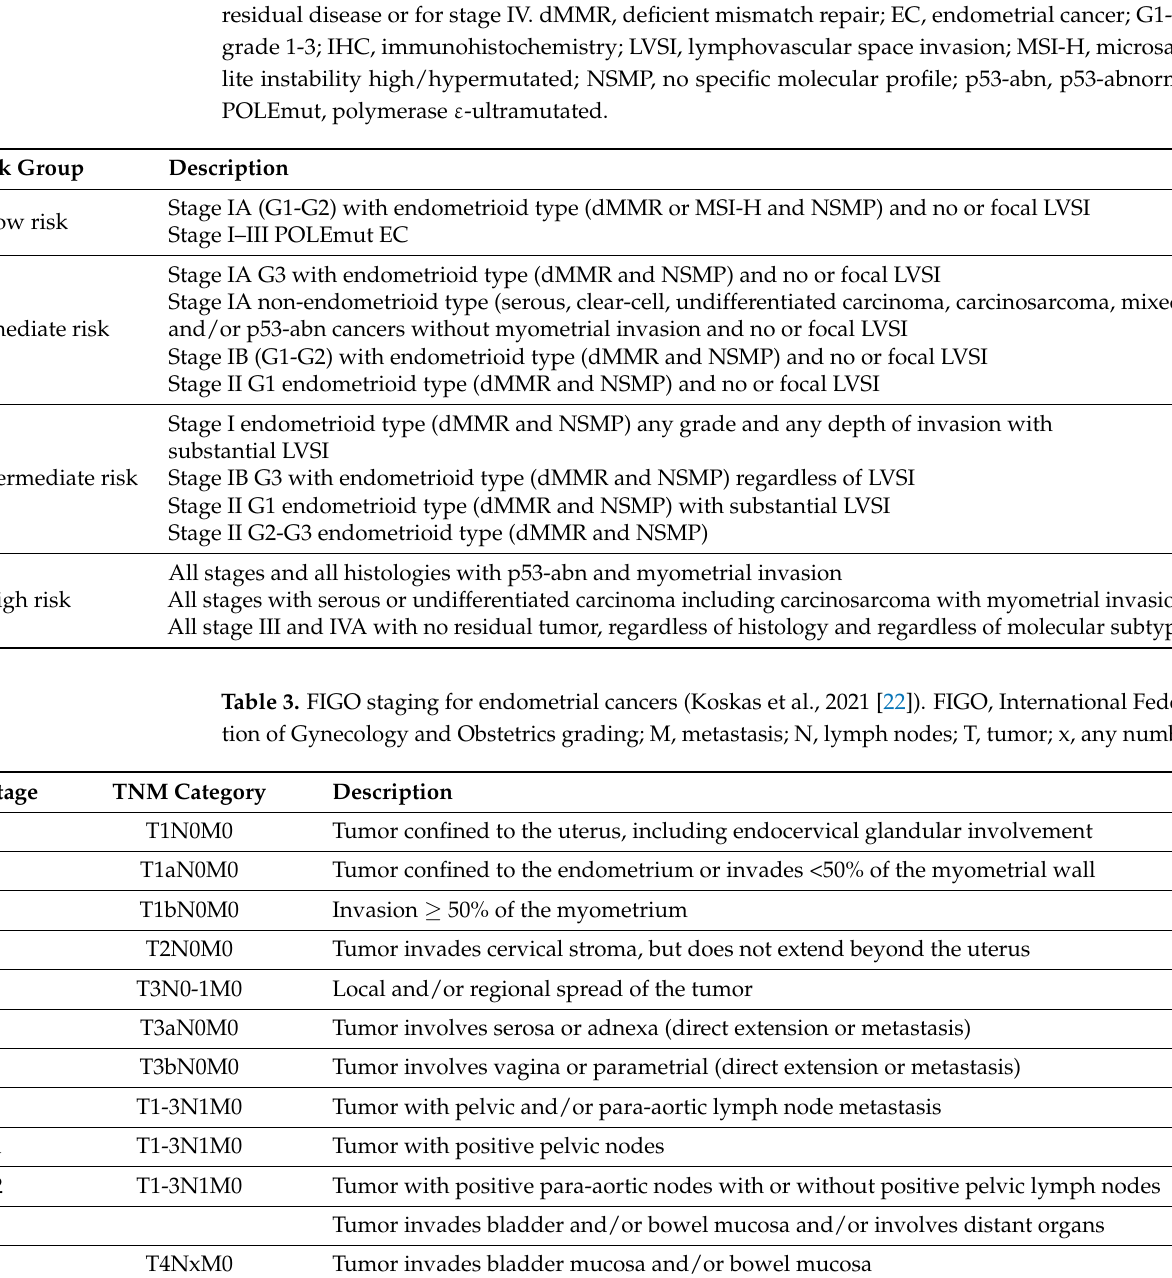
Table 2. Endometrial cancer risk groups (Oaknin et al., 2022 [5]). The table can be used in stage III-IVA with complete resection without residual disease and does not apply to stage III-IVA with residual disease or for stage IV. dMMR, deficient mismatch repair; EC, endometrial cancer; G1-G3, grade 1-3; IHC, immunohistochemistry; LVSI, lymphovascular space invasion; MSI-H, microsatel-